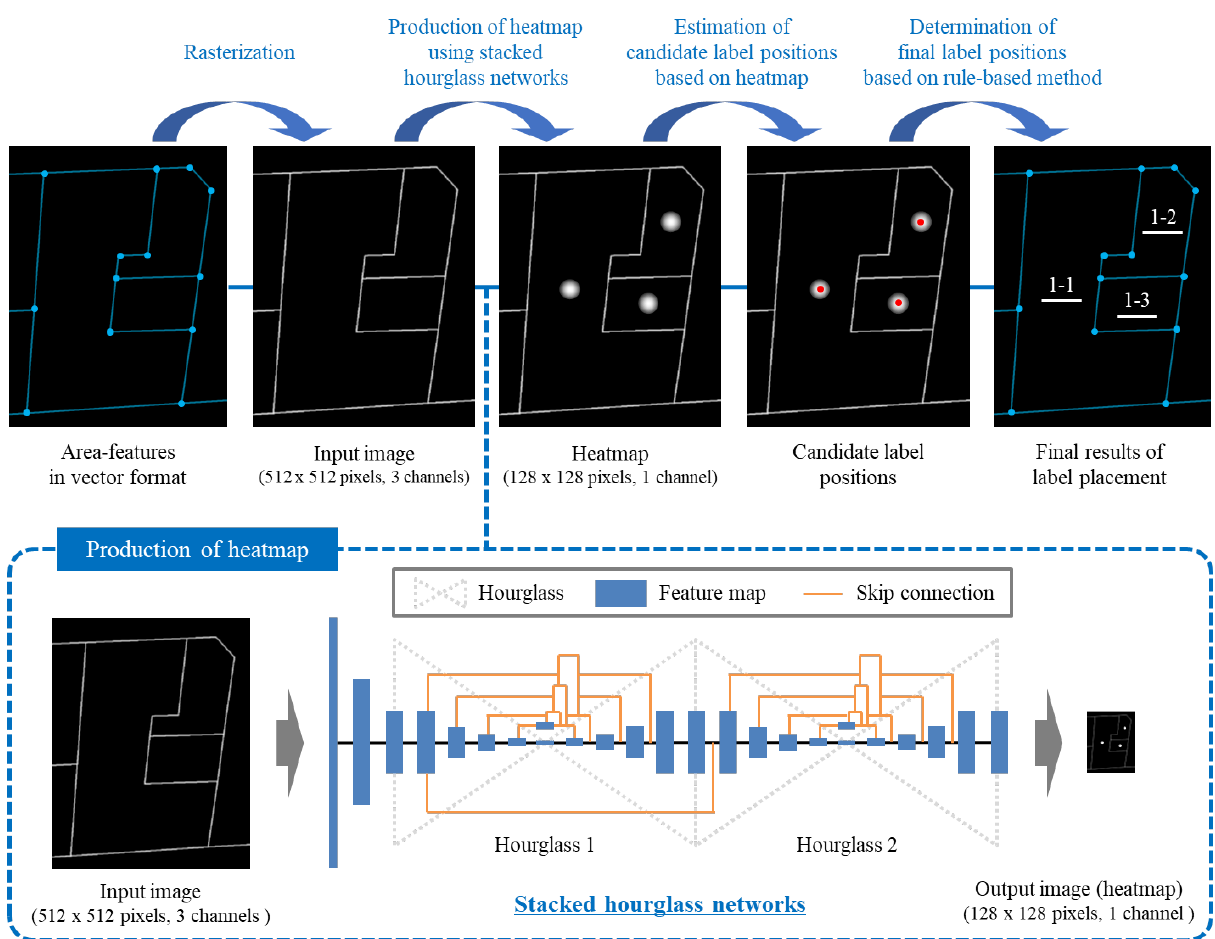
Figure 2. Process of proposed approach for area-feature label